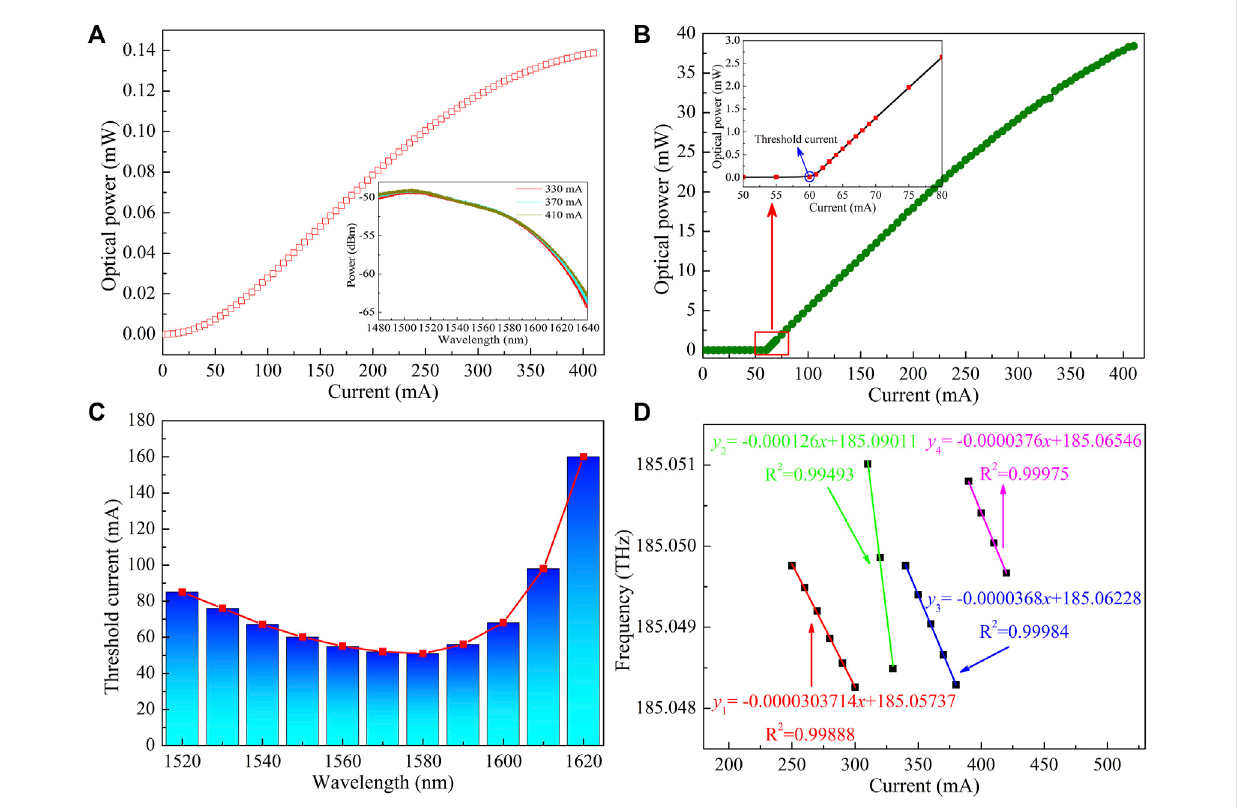
FIGURE 2 (A) Optical output power versus the injection current for the free-running single angled facet gain chip. Inset: gain spectra of the gain chip at different injection currents. (B) Measurement of the output power characteristics of the external-cavity wavelength-swept laser as a function of the injection current operating 1550 nm at a fi xed temperature of 25.0 ° C. (C) Threshold current of the proposed external-cavity wavelength-swept laser at different lasing wavelength. (D) Measurement lasing frequency shift as a function of the injection current in the proposed external-cavity con fi